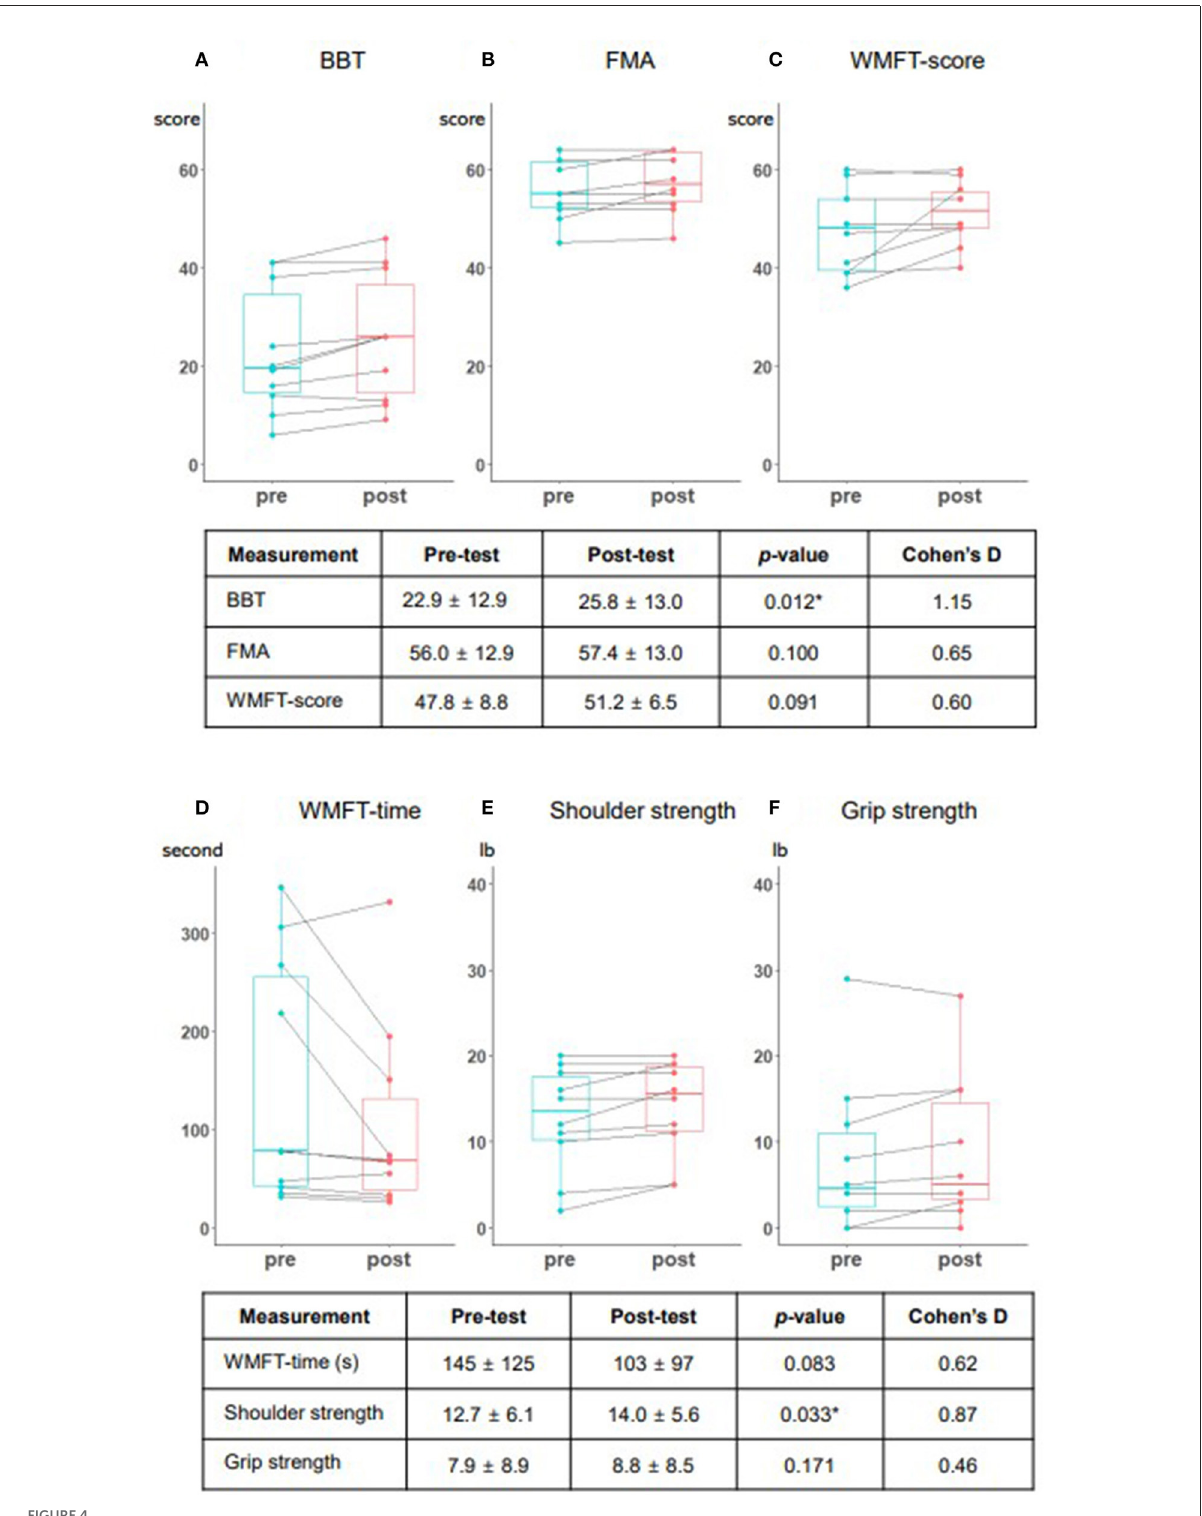
FIGURE4 Performance changes among the study patients presented in box plots. The box plots present the results of each outcome measurement and individual change. (A) Box and block test (BBT). (B) Fugl-Meyer assessment (FMA). (C) Wolf Motor Function Test (WMFT) score. (D) WMFT time. (E) Shoulder strength. (F) Grip strength. Each measurement includes the mean and standard deviation of the pre- and post-test, the p -value based on the Wilcoxon signed-rank test, and Cohen’s D score. BBT and shoulder strength were statistically significant ( p <